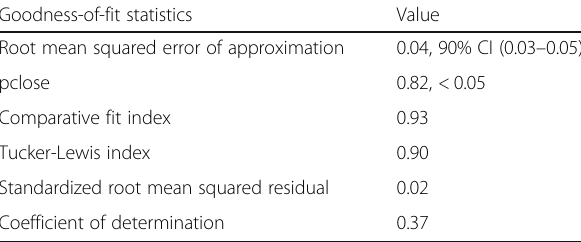
Table 3 Goodness-of-fit statistics for the structural equation model Goodness-of-fit